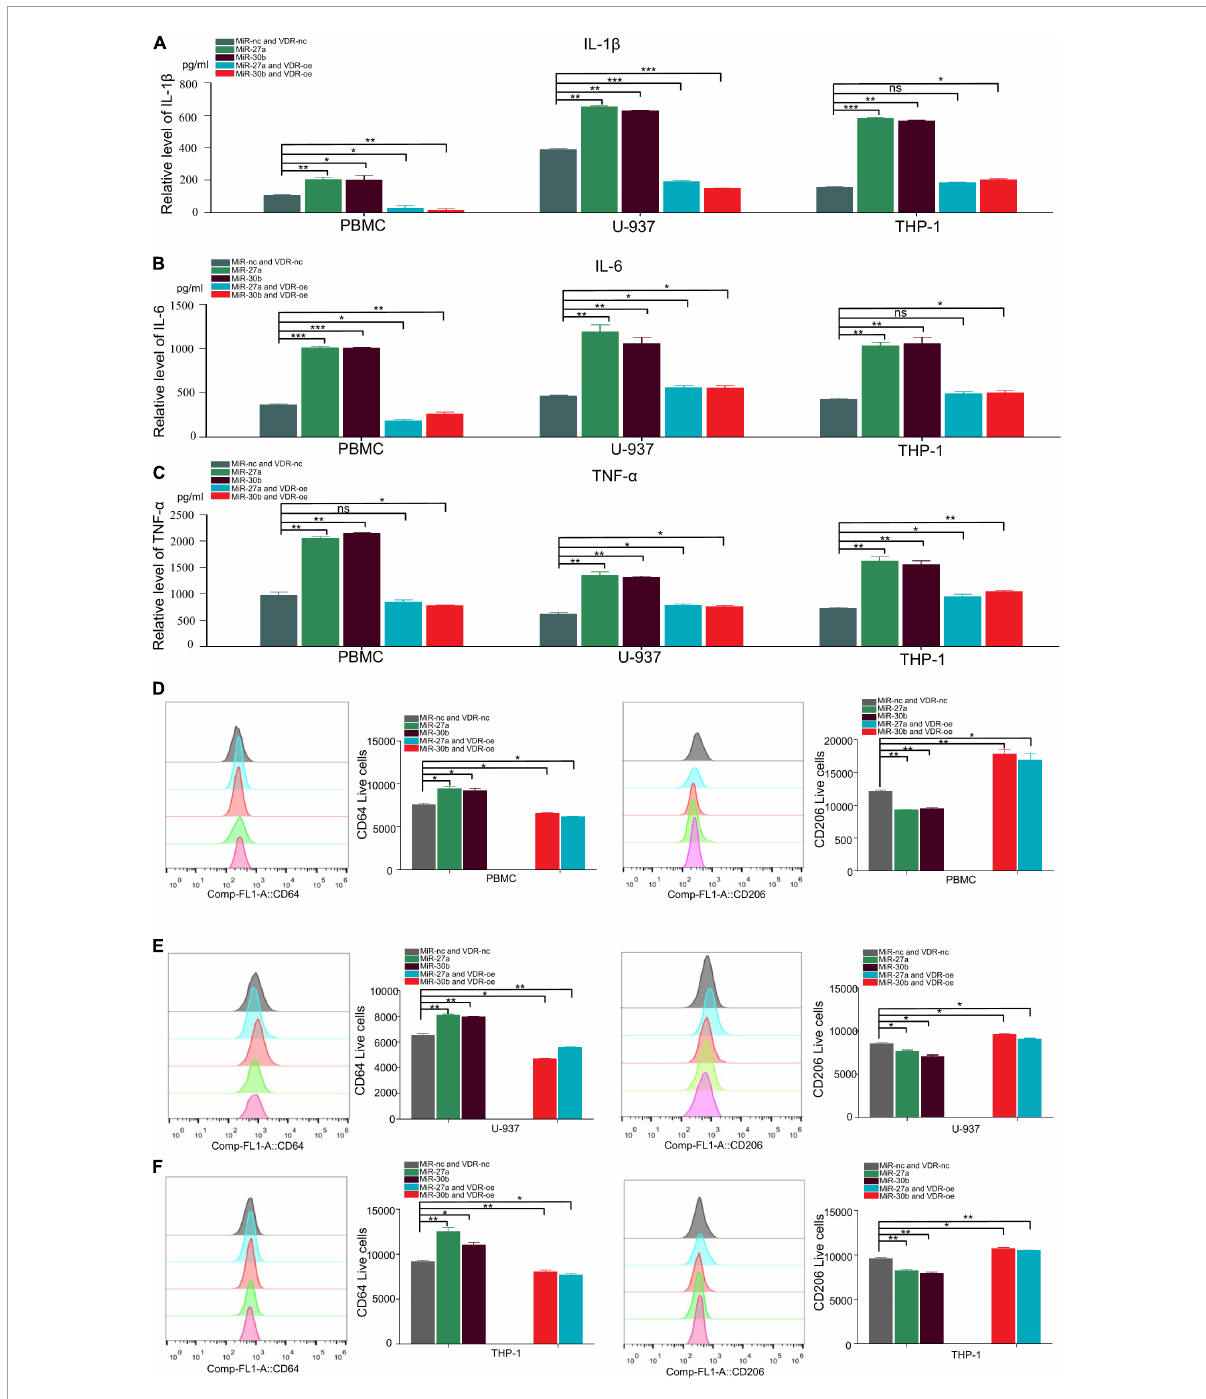
FIGURE6 Vitamin D receptor (VDR) reverses miR-27a-3p and miR-30b-5p mediated inflammatory cytokine expression and macrophage differentiation. (A) MiR-27a-3p, miR-30b-5p and negative control mimics were overexpressed in activated M1 macrophages. In addition, miR-27a-3p, miR-30b-5p and negative control mimics together with VDR plasmids were transfected in another group. After 48 h, the levels of the cytokine IL-1 β in the activated M1 macrophages of both groups were measured. (B,C) The relative levels of IL-6, TNF- α in the activated M1 macrophages of the VDR and negative control groups. (D) miR-27a-3p, miR-30b-5p and negative control mimics were overexpressed in PBMC M1 macrophages as a control group, while miR-27a-3p, miR-30b-5p and negative control mimics together with VDR plasmids were transfected into the VDR-OE group. The proportion of PBMCs expressing CD64 (marker of M1 macrophages) and CD206 (marker of M2 macrophages) were determined by flow cytometry. (E) The proportion of U-937 expressing CD64 and CD206 were determined by flow cytometry. (F) The proportion of THP-1 expressing CD64 and CD206 were determined by flow cytometry. * P < 0.05, ** P < 0.01, *** P < 0.001, **** P < 0.0001, ns=not